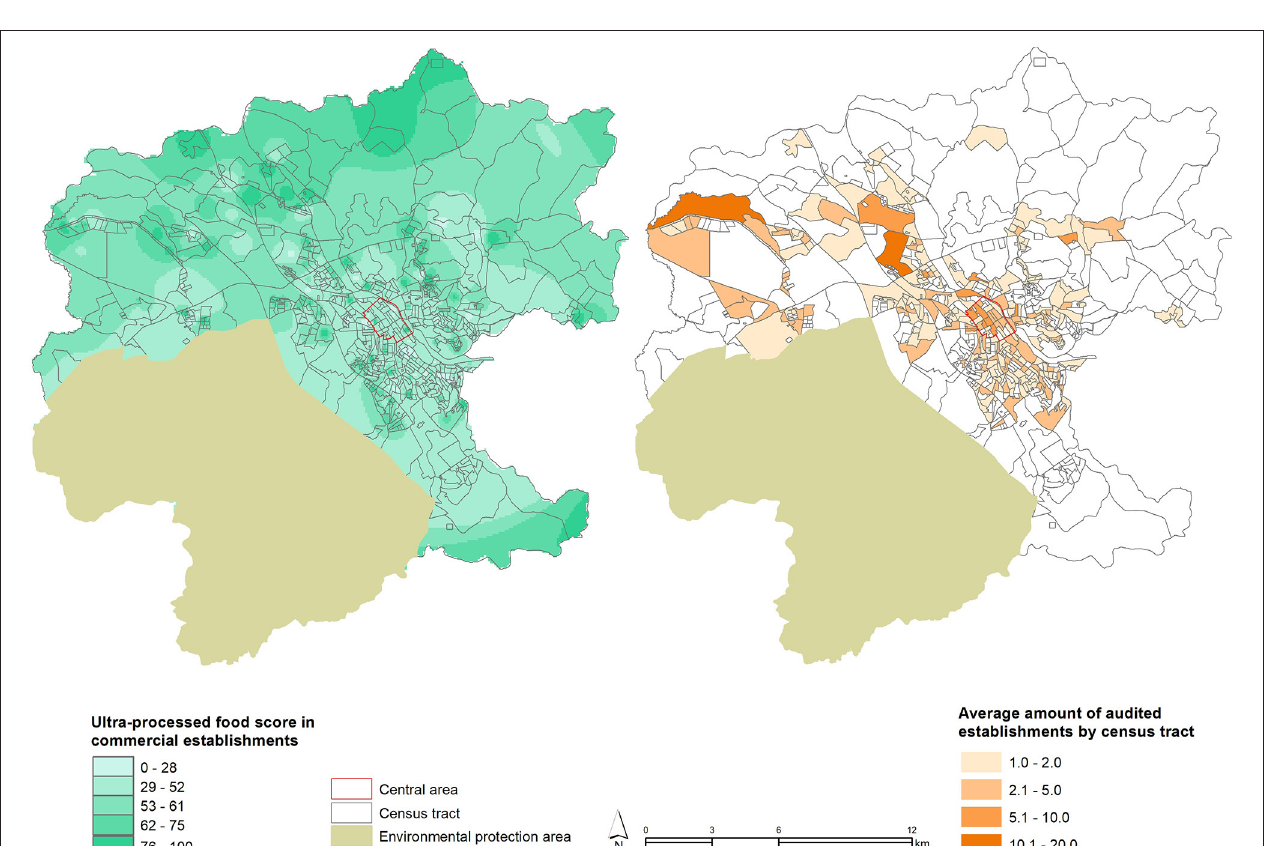
healthiness score in a sample of food retailers, the